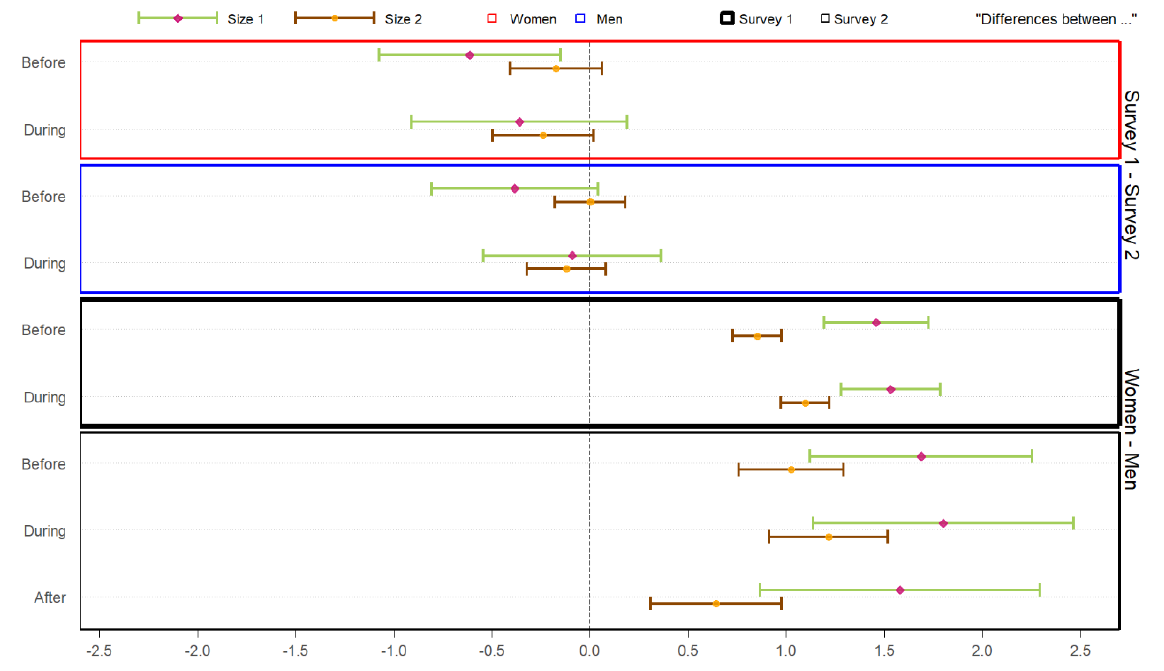
Figure 4. Confidence intervals of mean differences between surveys by gender, period and municipality size (upper panels) and between genders by municipality size and period of time (lower panels). The upper panels of this figure show the confidence intervals for the mean differences between surveys by period of time with respect to confinement, differentiating between municipality sizes and genders. The lower panels show the confidence intervals for the mean differences between genders by period of time with respect to confinement, differentiating between municipality sizes. Differences are not significant at 5% level when the corresponding interval intersects with the zero-vertical dotted line. The interested reader can find detailed numbers, including p-values, in Table A3 of Appendix A.